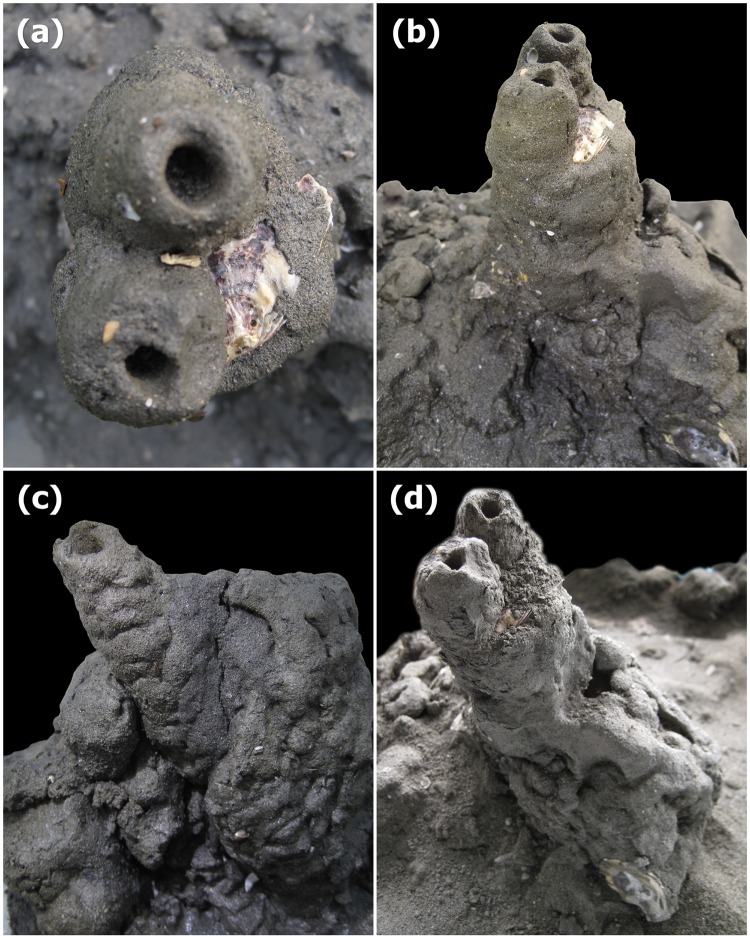
Photo of the mud shrimp burrow wall.Top view of the burrow showing the opening (a), the trunk of the burrow gradually thickening with depth (b), irregular deposition of the clay in the burrow wall (c), and intact morphology of the burrow wall 1 year after collection (d).